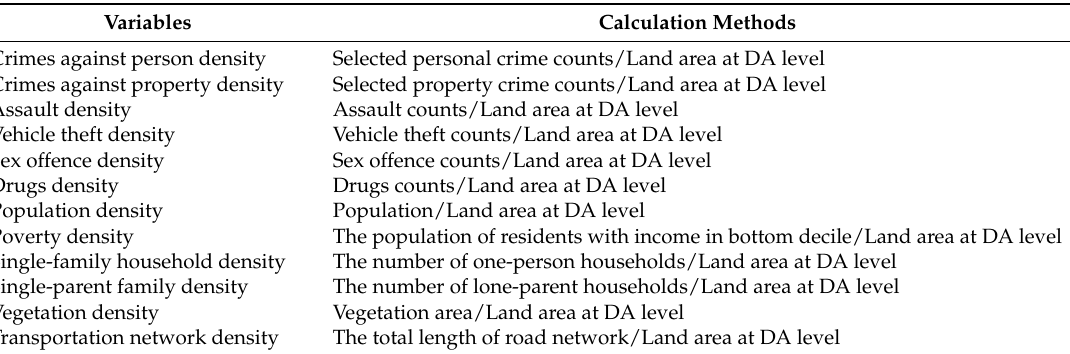
Table 1. Dependent and independent variables.